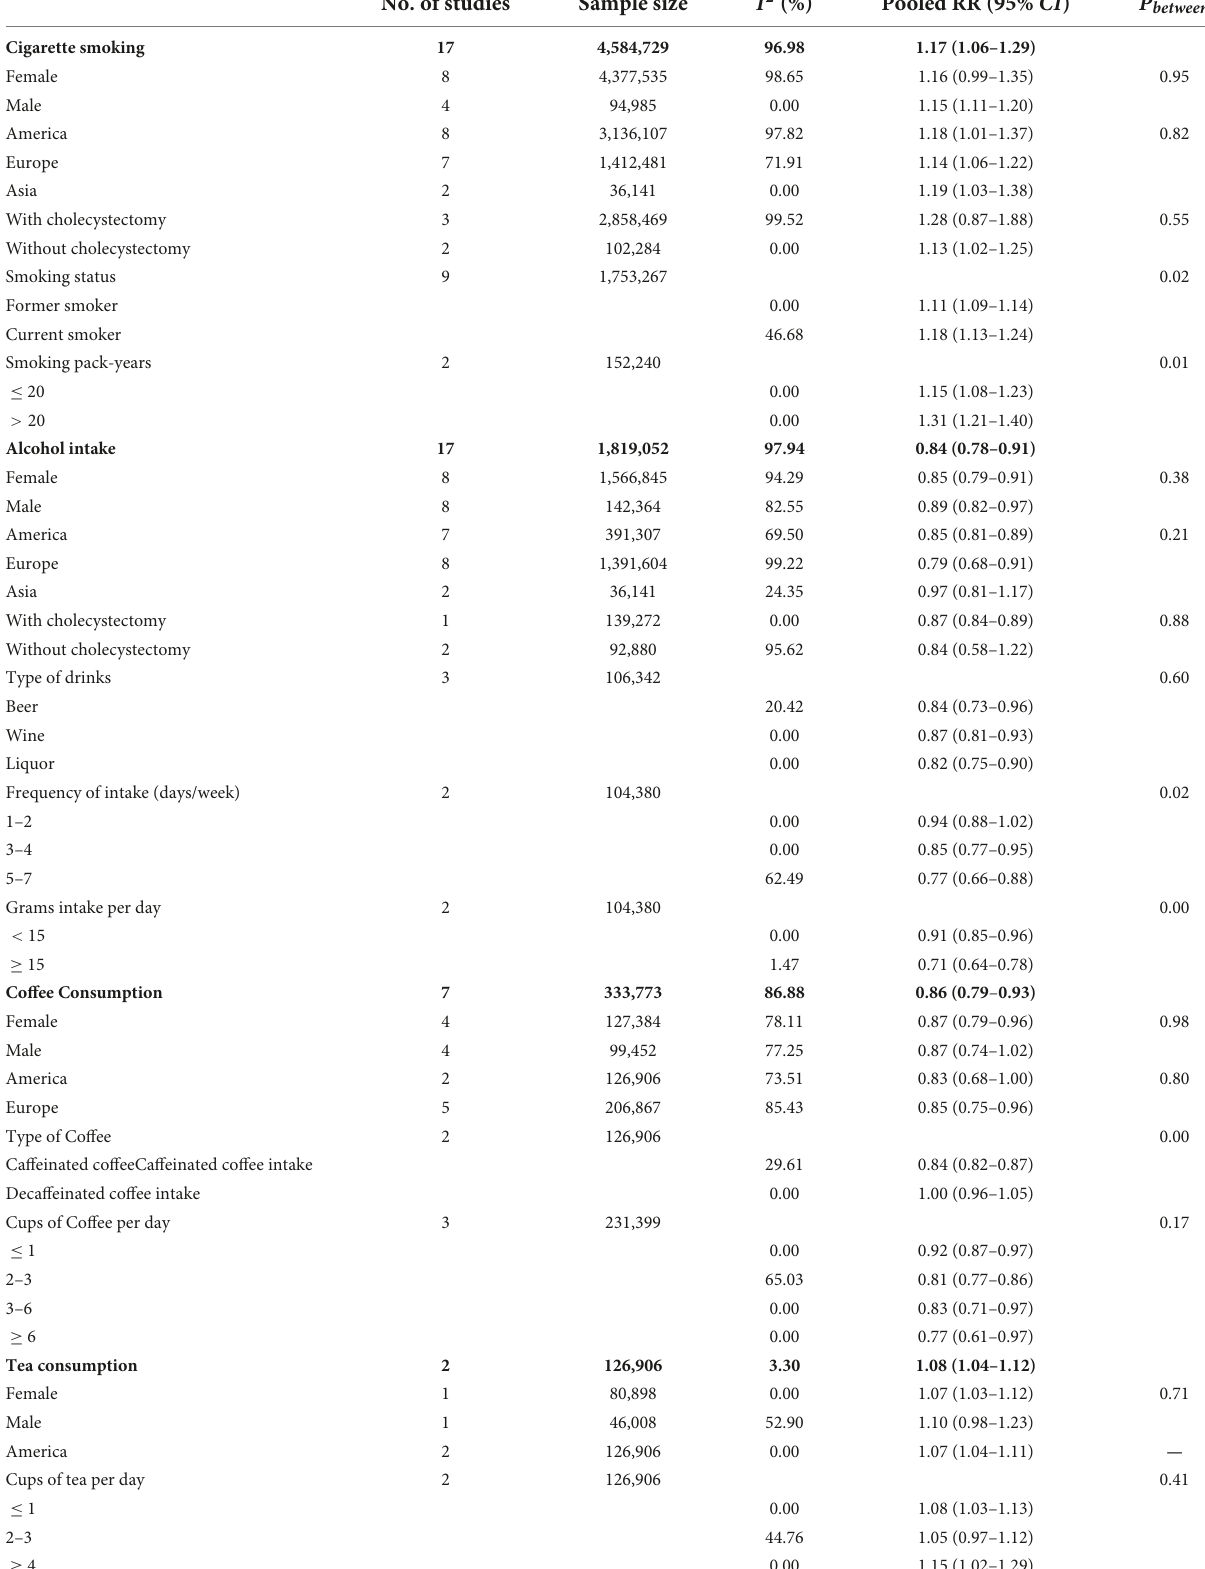
TABLE 1 Addictive behaviors risks for gallstone disease included in meta-analysis. No. of